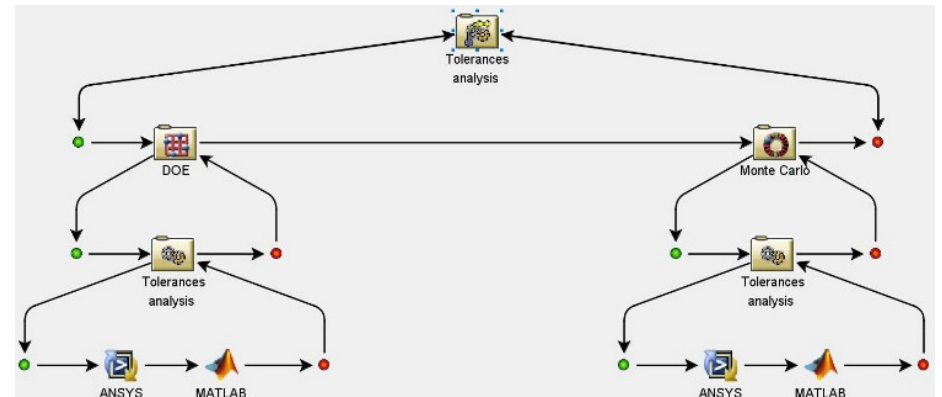
Figure 7. Integrated simulation link based on Monte Carlo.